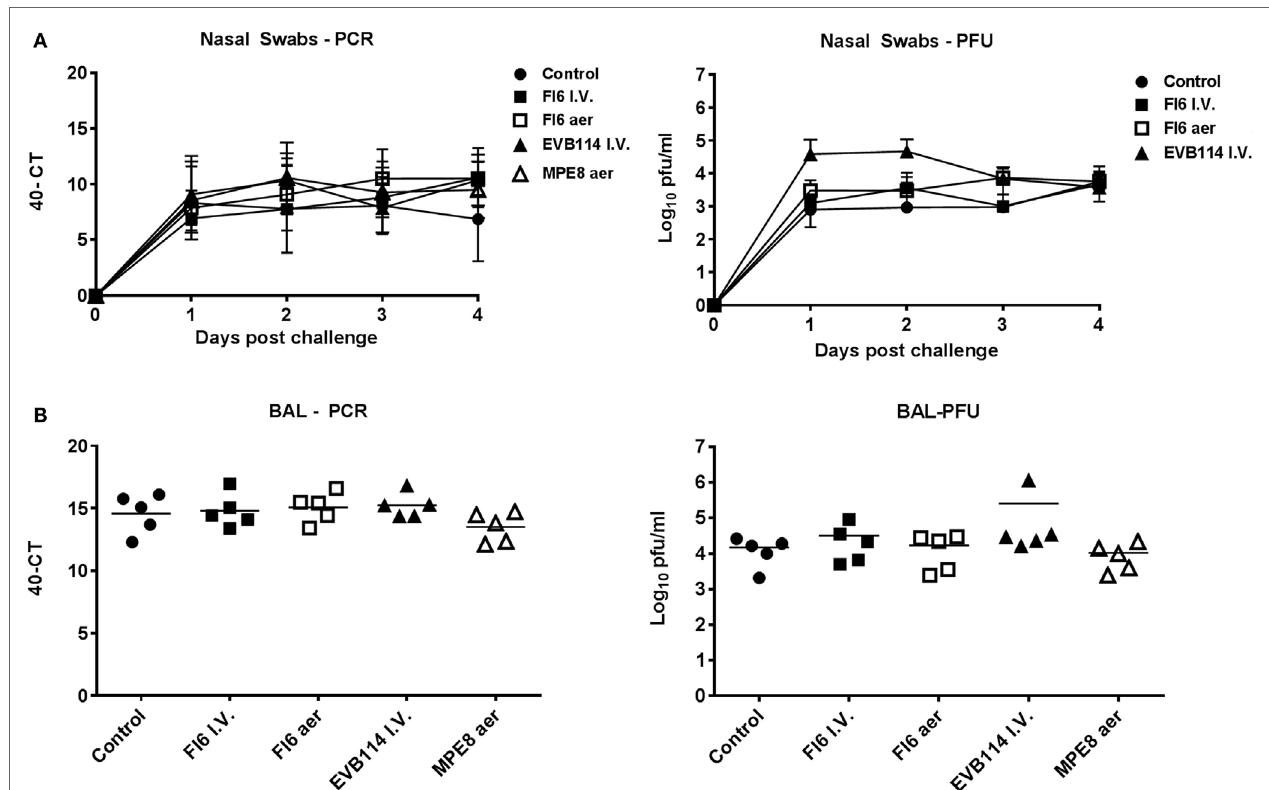
FigUre 2 | Viral load in nasal washes and broncho-alveolar lavage (BAL). Pigs were infected with A/sw/Eng/1353/09 and administered the indicated antibodies either by the I.V. route (I.V. solid symbols) or by aerosol (aer, hollow symbols). Nasal swabs (NS) were taken at 0, 1, 2, and 3 day post infection (dpi) and pigs sacrificed at 4 dpi. Viral titers in the nasal swabs (a) and BAL (B) were determined by plaque forming assay or real-time quantitative reverse transcriptase polymerase chain reaction. Each data point represents an individual within the indicated group and bars represent the